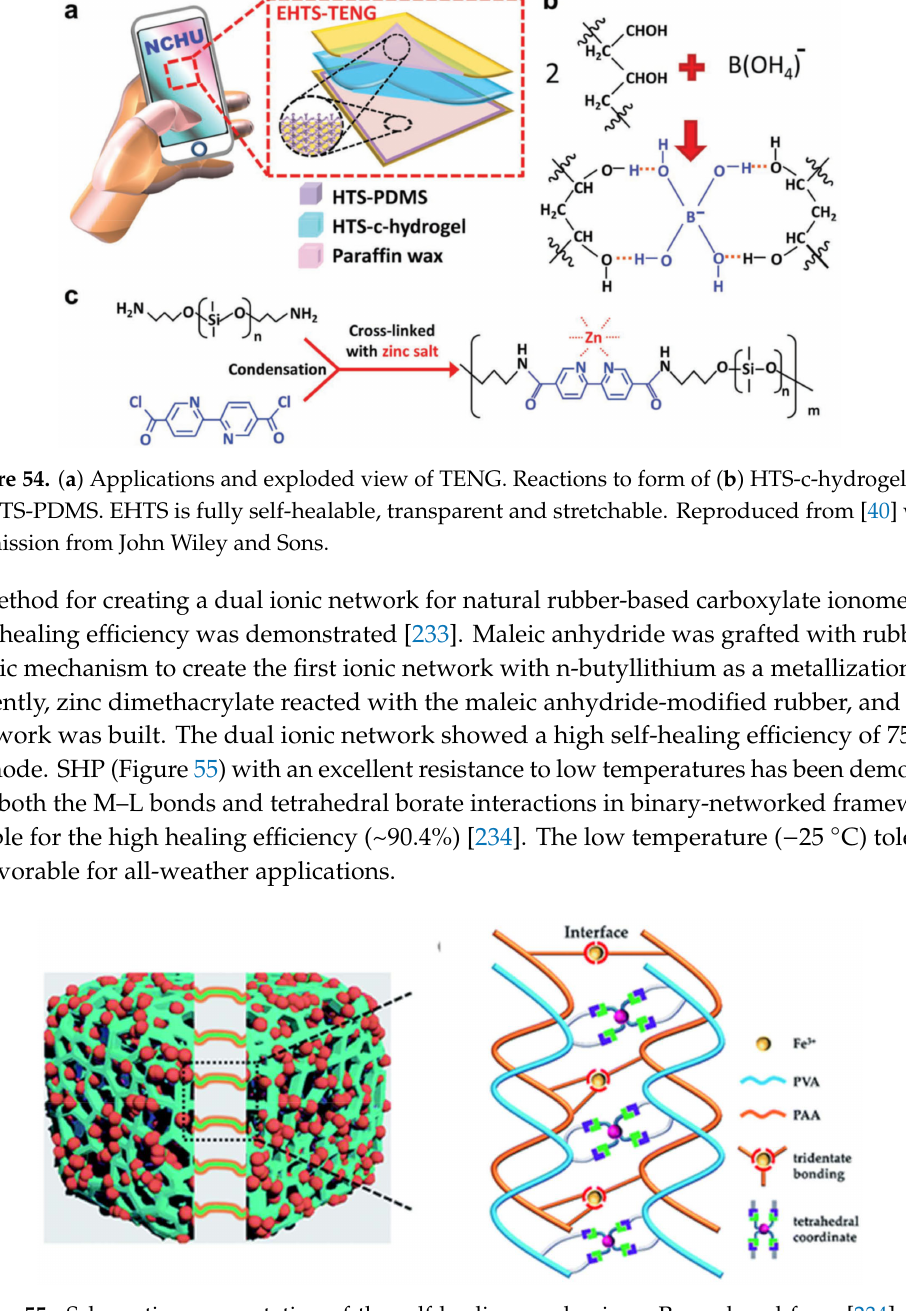
Figure 55. Schematic representation of the self-healing mechanism. Reproduced from [234] with permission from The Royal Society of